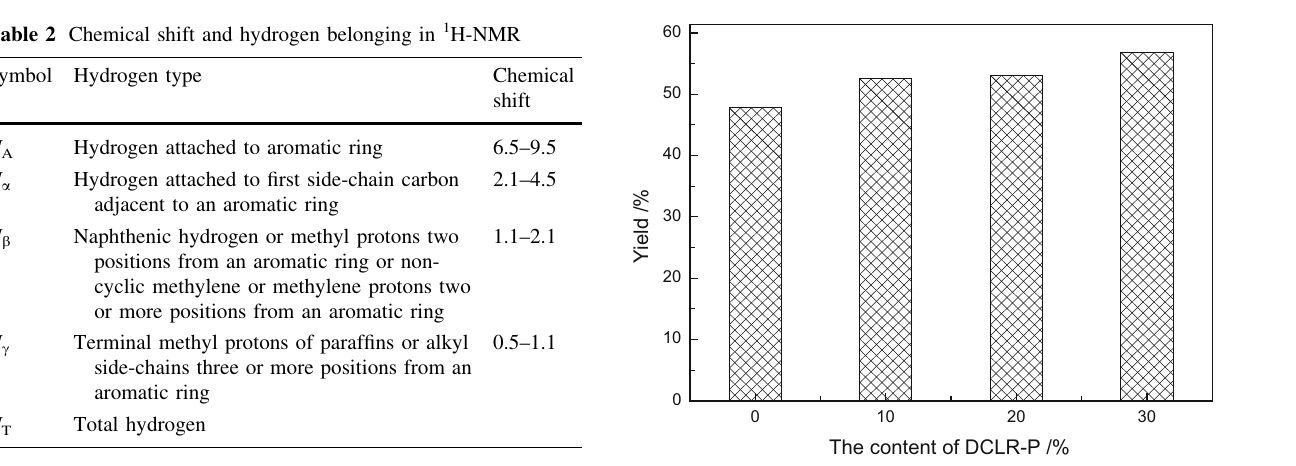
Fig. 1 Yields of MCMBs with different contents of DCLR-P